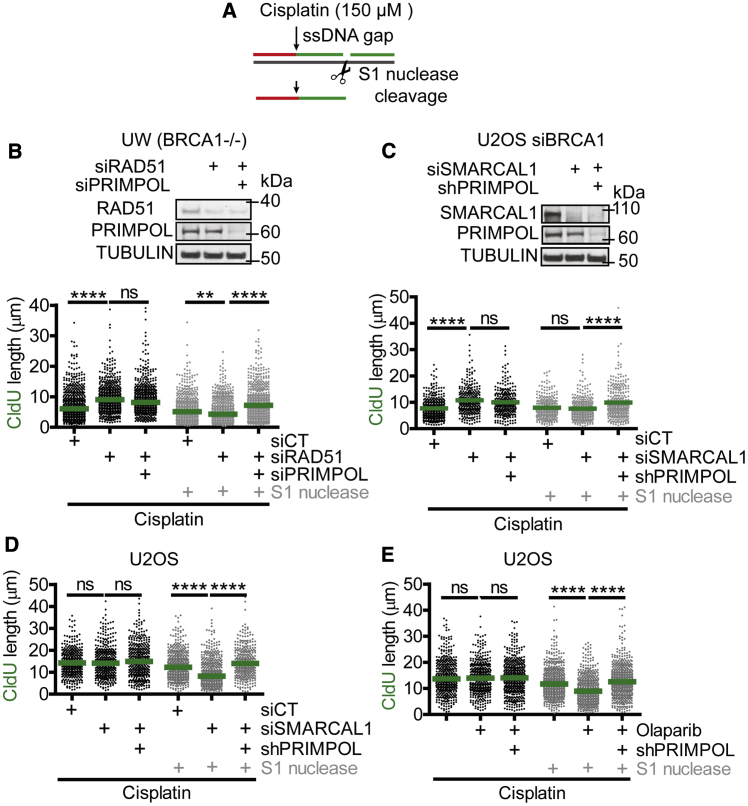
Depletion of Fork Reversal Factors Leads to Accumulation of PRIMPOL-Dependent ssDNA Gaps(A) Schematic for detection of ssDNA gaps using the ssDNA-specific S1 nuclease upon treatment with cisplatin (150 μM).(B) Expression of RAD51 and PRIMPOL after siRNA (siRAD51 and siPRIMPOL) knockdown in UW cells 48 h after transfection (top). Dot plot and median of CldU tract lengths upon treatment with 150 μM cisplatin in UW cells depleted for RAD51, PRIMPOL, or RAD51/PRIMPOL ± S1 nuclease (bottom) (n = 3). ns, non-significant, ∗∗p < 0.01, ∗∗∗∗p < 0.0001.(C) Expression of SMARCAL1 48 h after depletion with siRNA (siSMARCAL1) and PRIMPOL upon addition of doxycycline (DOX) in U2OS siBRCA1 cells stably expressing a DOX-inducible shPRIMPOL (shPRIMPOL) (top). Dot plot and median of CldU tract lengths upon treatment with 150 μM cisplatin in U2OS siBRCA1 cells depleted for SMARCAL1, PRIMPOL, or SMARCAL1/PRIMPOL ± S1 nuclease (bottom) (n = 2). ns, non-significant, ∗∗∗∗p < 0.0001.(D) Dot plot and median of CldU tract lengths upon treatment with 150 μM cisplatin in U2OS cells depleted for SMARCAL1, PRIMPOL, or SMARCAL1/PRIMPOL ± S1 nuclease (bottom) (n = 3). ns, non-significant, ∗∗∗∗p < 0.0001.(E) Dot plot and median of CldU tract lengths upon treatment with 150 μM cisplatin in U2OS cells depleted for PRIMPOL (shPRIMPOL) ± PARPi and ± S1 nuclease (n = 3). ns, non-significant, ∗∗∗∗p < 0.0001.See also Figure S5.